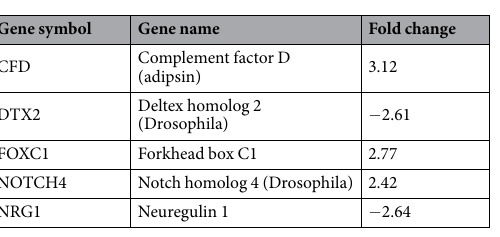
Table 8. List of genes belonging to Notch signalling pathway that were significantly over expressed between week 1 and 2 (positive value indicates up-regulation at week 3).